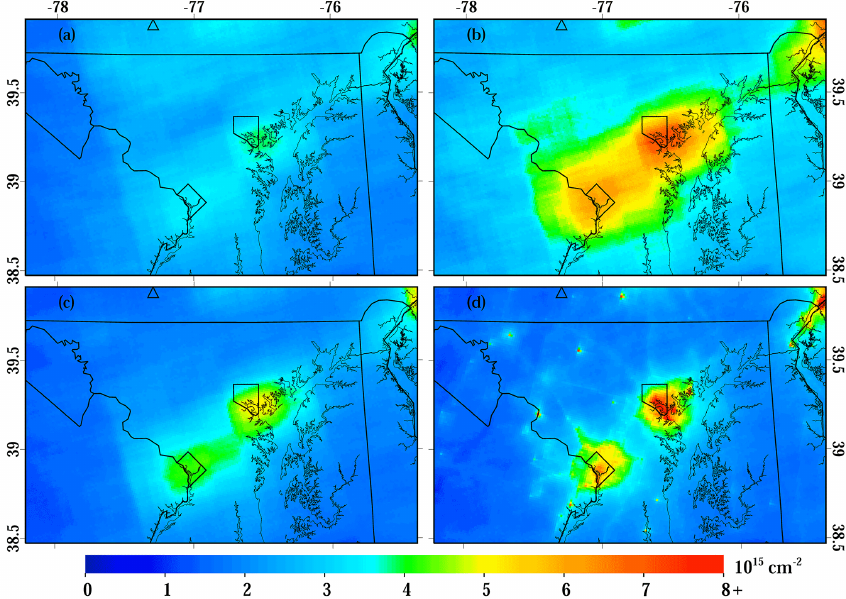
Figure 4. Oversampled OMI NO 2 tropospheric columns at 1.33km resolution in the Baltimore–Washington metropolitan area for June and July 2008–2012 (2 months × 5 years; 10 months total). (a) The NASA version 3.0 operational OMI NO 2 product using GMI NO 2 shape profiles (OMI_GMI). (b) OMI NO 2 using CMAQ a priori NO 2 shape profiles (OMI_CMAQ). (c) OMI NO 2 using CMAQ a priori NO 2 shape profiles constrained by observations (OMI_CMAQ _O). (d) OMI NO 2 using CMAQ a priori NO 2 shape profiles constrained by observations and spatial weighting downscaling kernels (OMI_CMAQ_OD). In all plots, Arendtsville, PA, is denoted by the triangle in the top left